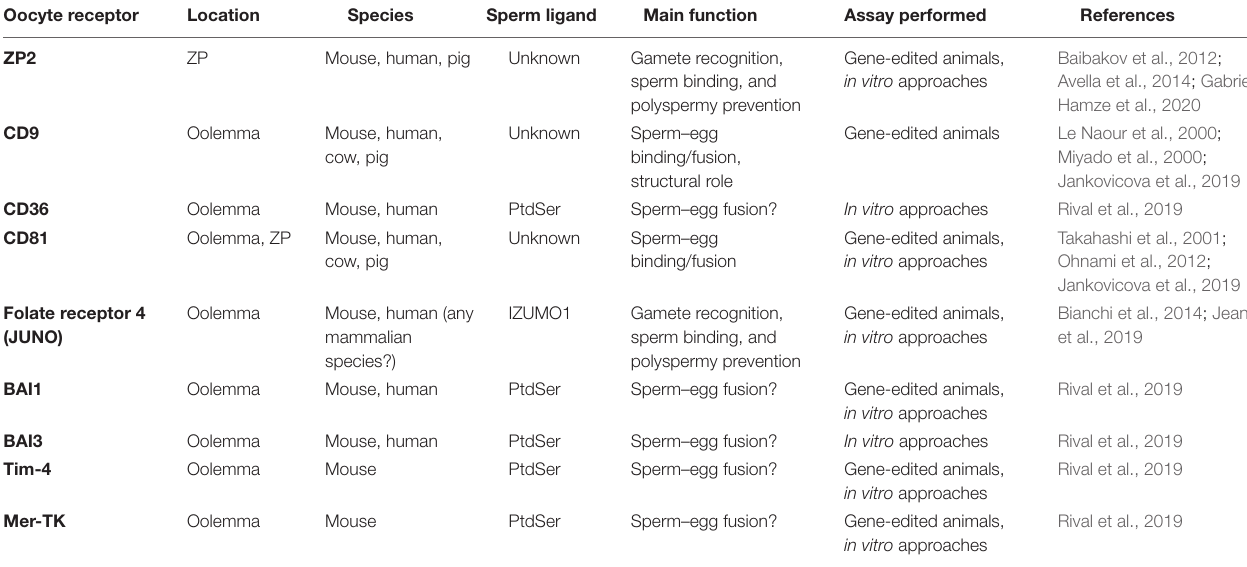
TABLE 1 | Summary of oocyte’s receptors involved in mammalian fertilization known to